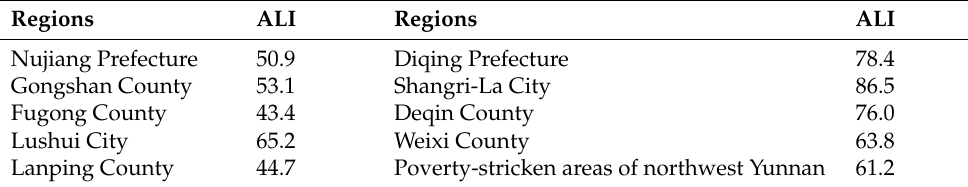
Table 5. Geographical environment adaptation level of resettled population in the study